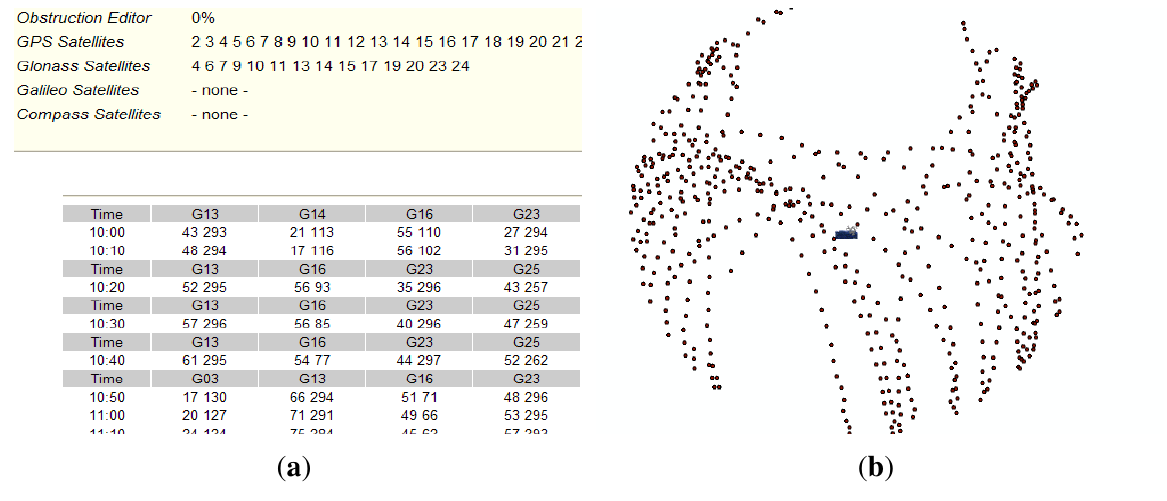
Figure 5. Calculating satellite positions ( a ) prediction results from Trimble Planning for 10 min intervals over the test site ( b ) a 2D plot of pseudo satellites positions at 10 min intervals over Maynooth University between 10:00 and